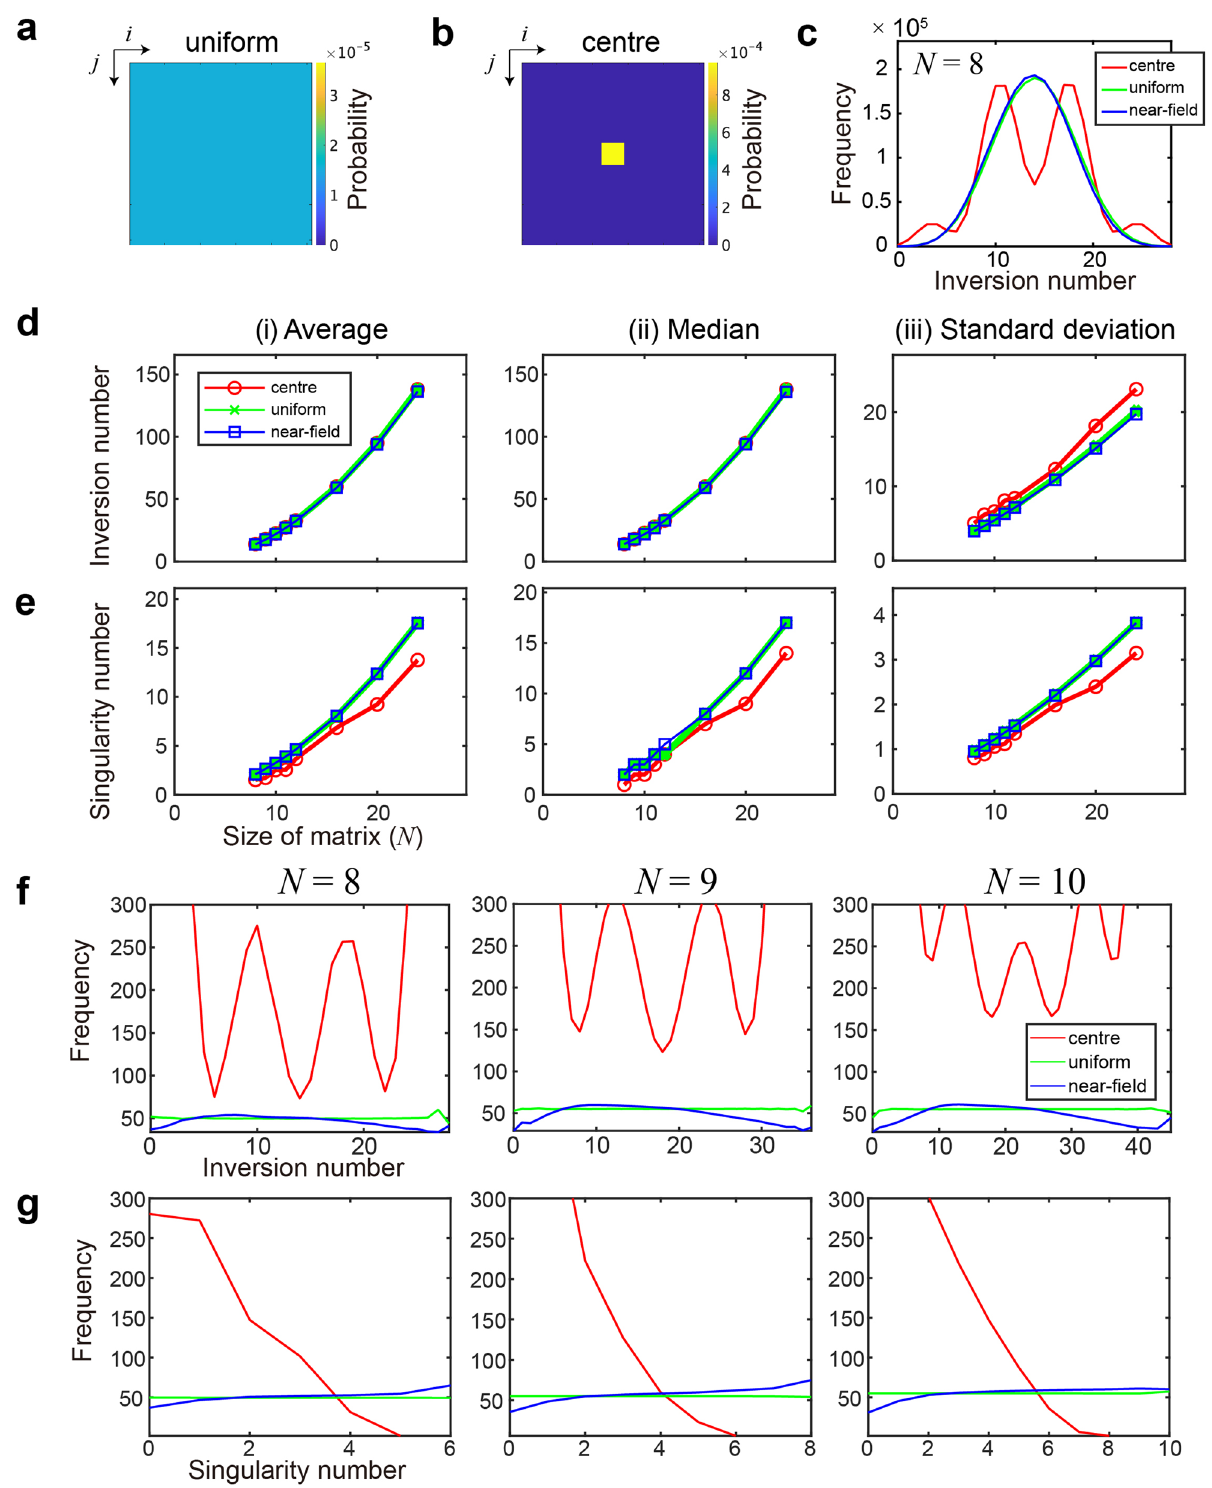
Figure 6. Characterization of Schubert polynomials generated by the near-field pattern compared with the ( a ) uniformly distributed and ( b ) spatially strongly skewed (centred) patterns. ( c ) Inversion number distribution when N = 8 by the near-field, uniform, and centre patterns. ( d , e ) Basic statistical analysis of the ( d ) inversion number and ( e ) singularity number as a function of the size of the matrix ( N ). (i) Average, (ii) median, and (iii) standard deviations are examined and no evident differences among the sources are observed. ( f , g ) When the incidence is normalized by the number of unique matrices, evident source dependencies are observed in both the ( f ) inversion number and ( g ) singularity